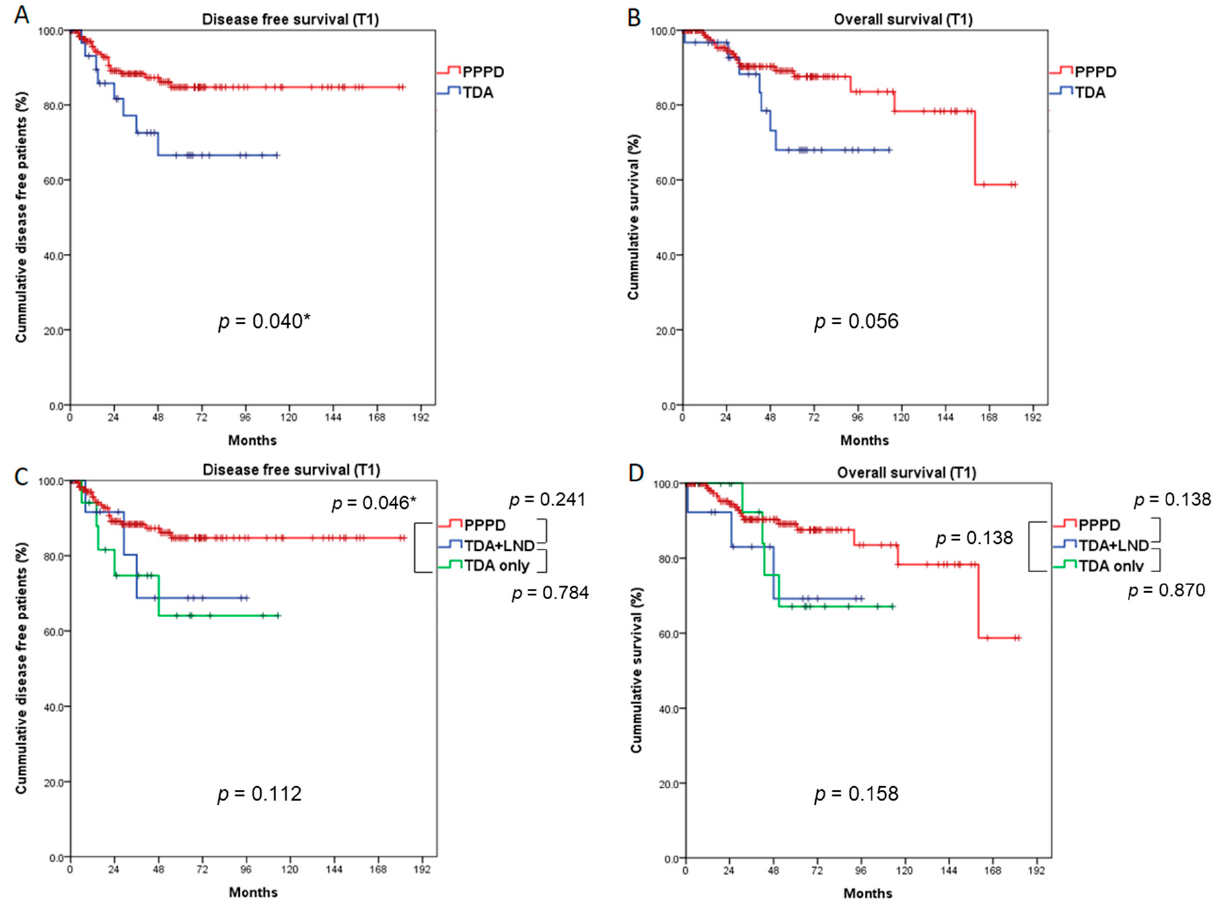
Figure 4. Comparison of survival outcomes between the PPPD and TDA groups (T1 patients). Five-year disease-free survival ( A ) was significantly better after PPPD than TDA ( p = 0.040). Five-year overall survival ( B ) was marginally better in the PPPD group than the TDA group ( p = 0.056). When the TDA group was divided into TDA + LND and TDA-only groups, the PPPD group showed better disease-free survival than the TDA-only group ( p = 0.046), but disease-free survival did not differ between the PPPD and TDA+LND groups ( C ). Five-year overall survival ( D ) did not differ among the three groups. LND: lymph node dissection. * statistically significant ( p < 0.050)